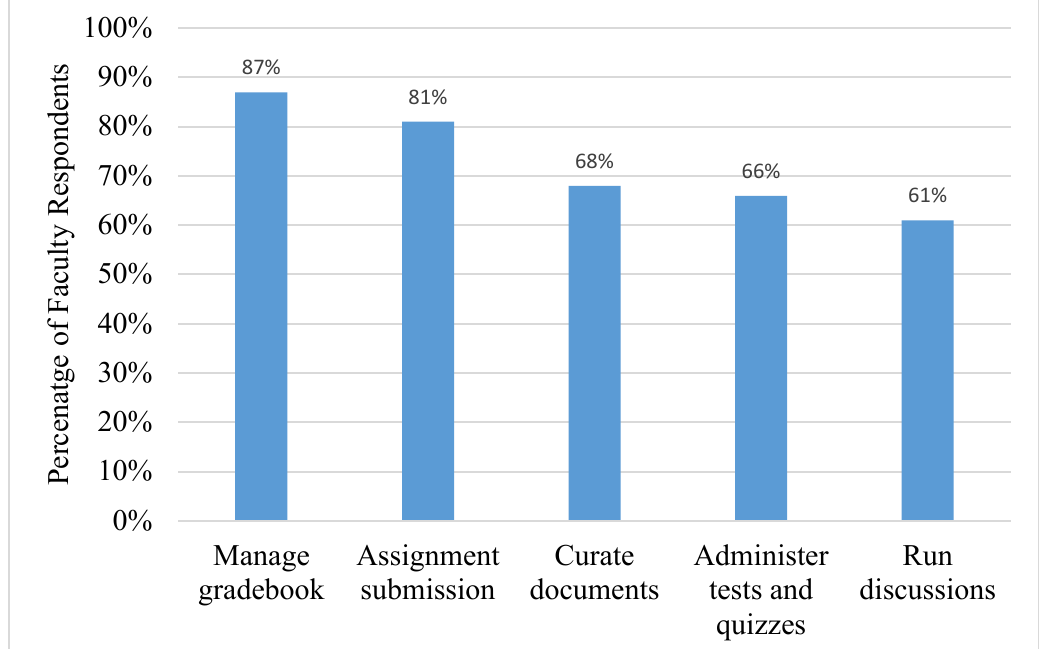
Figure 5 . Ways faculty used the learning management